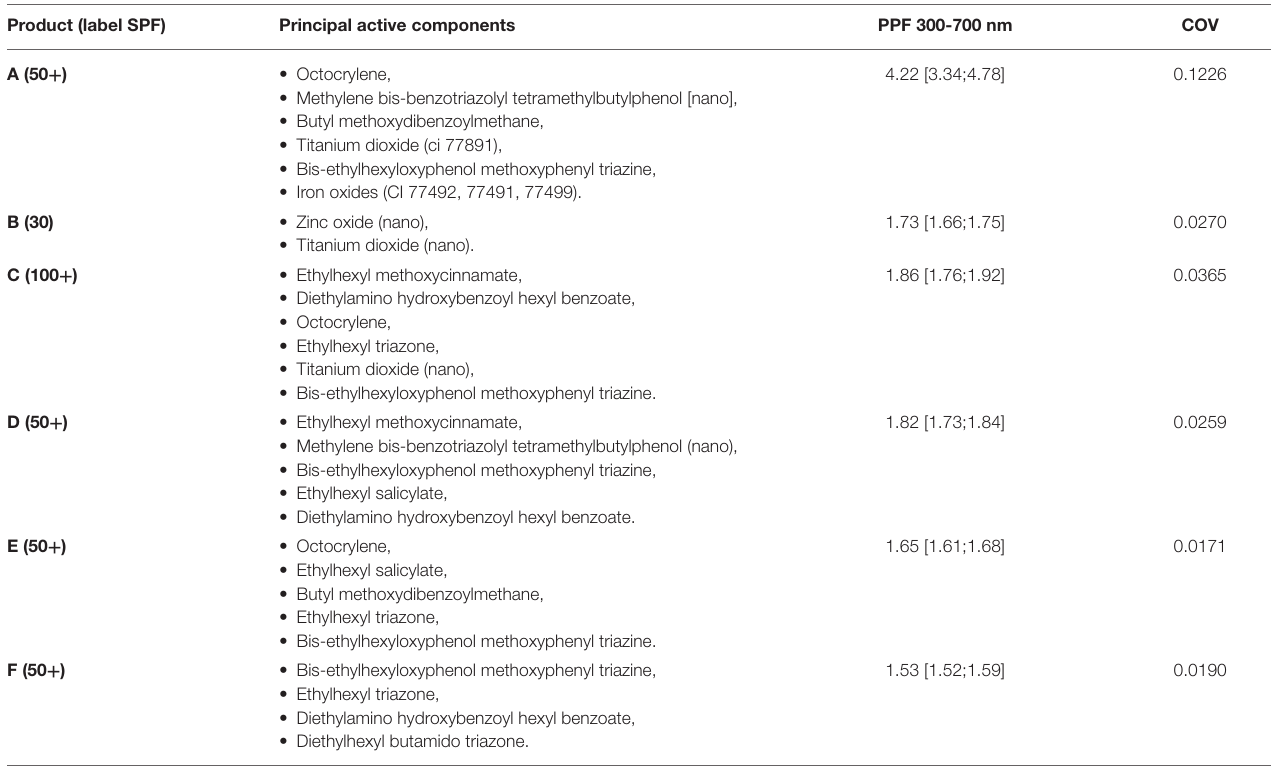
TABLE 1 | Labeling information with SPF, filter type and results of PPFs measurements in the 300–700nm wavelengths of the six tested solar filters, expressed as median [min;max]. COV, coefficient of